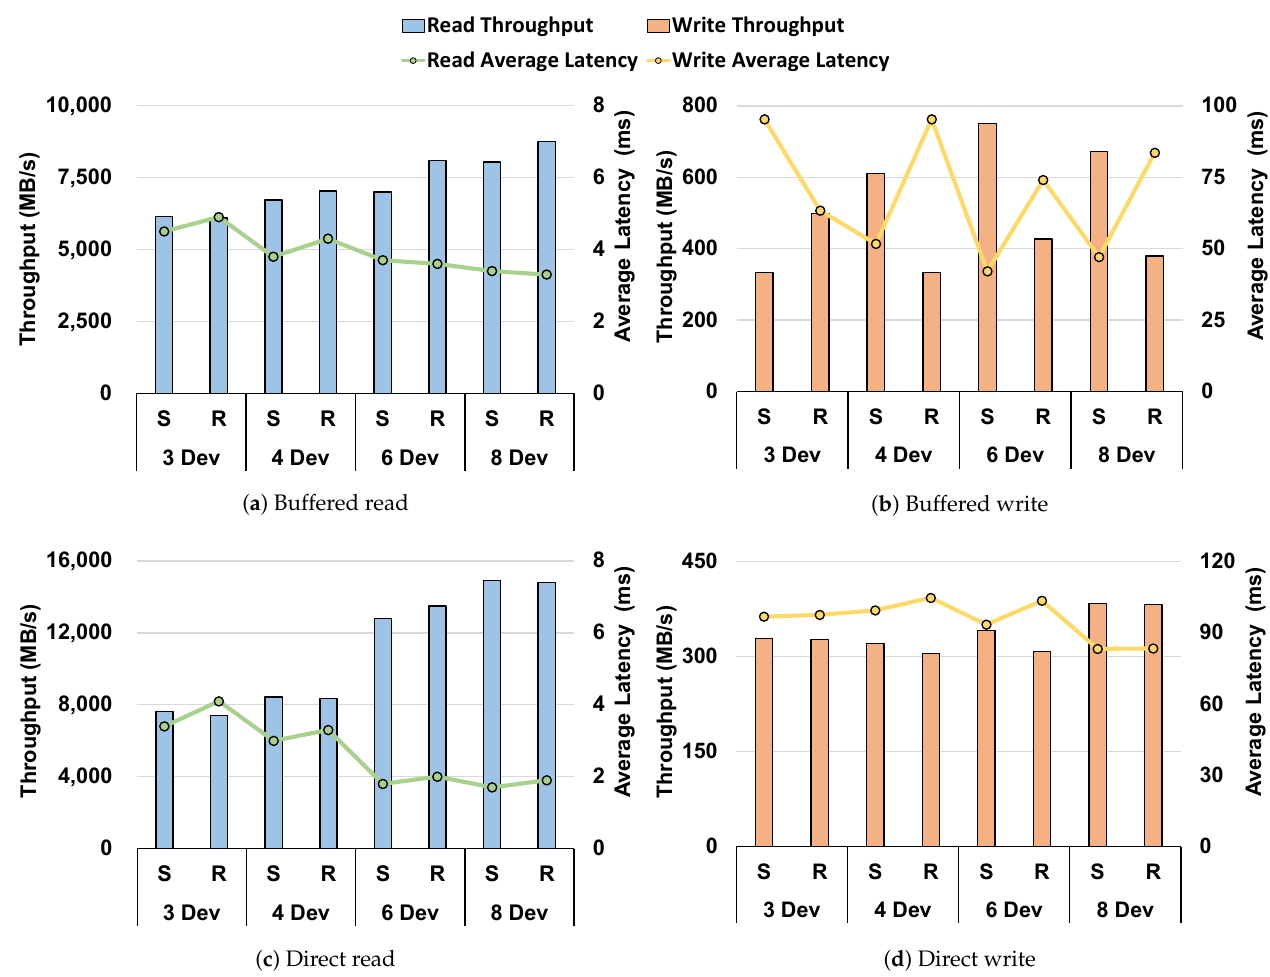
Figure 4. Experimental results under RAID 5 (S: sequential, R: random, Dev: number of